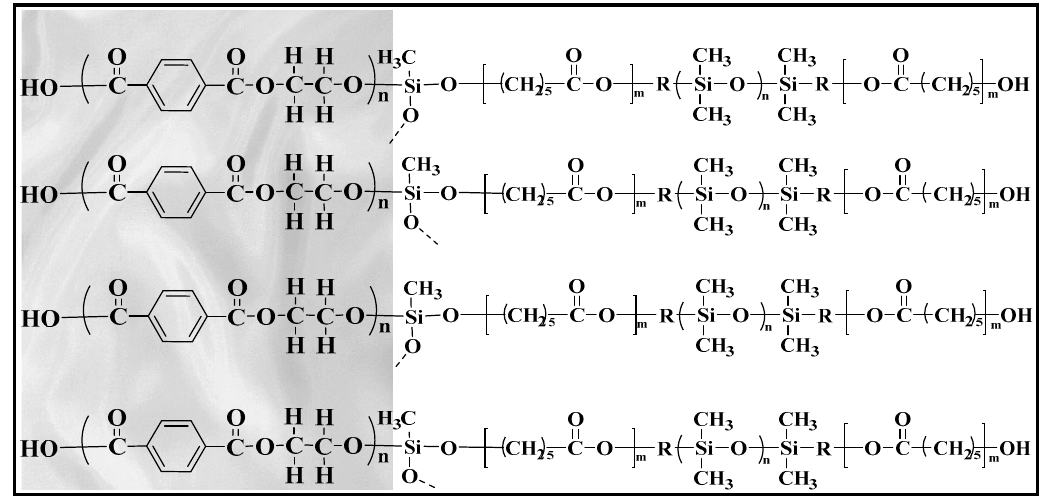
Figure 2. Schematic representation of sol-gel poly(caprolactone-dimethylsiloxane-caprolactone) coating, chemically bonded to the polyester fabric substrate.